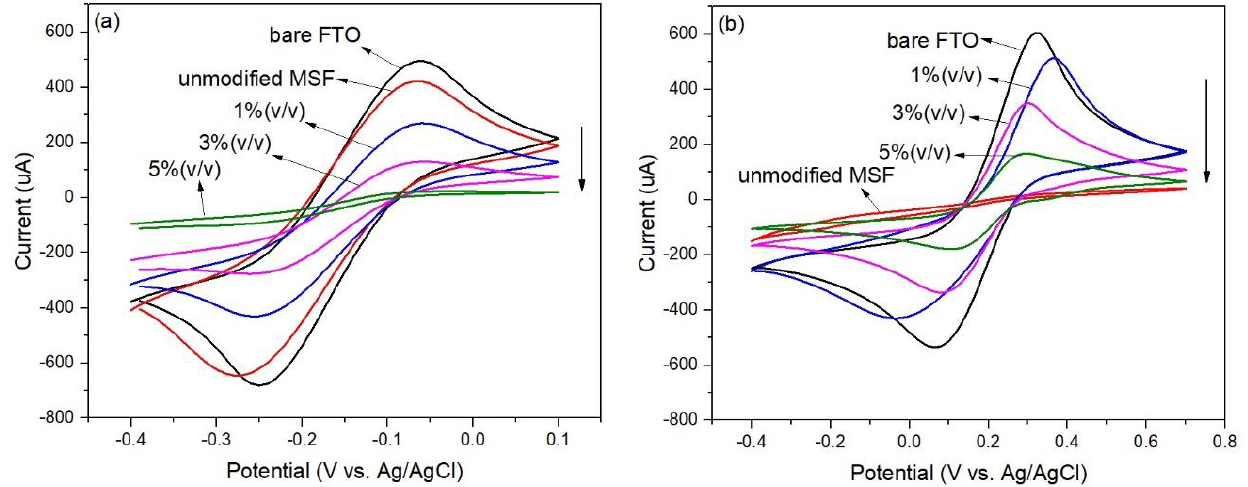
Figure 4. Cyclic voltammograms of MSFs modified with various concentrations of APTES in 0.1 M NaNO 3 solution containing 5 mM Ru(NH 3 ) 63+ ( a ) and 5 mM Fe(CN) 63 − ( b ) at scan rate of 0.1 Vs –1